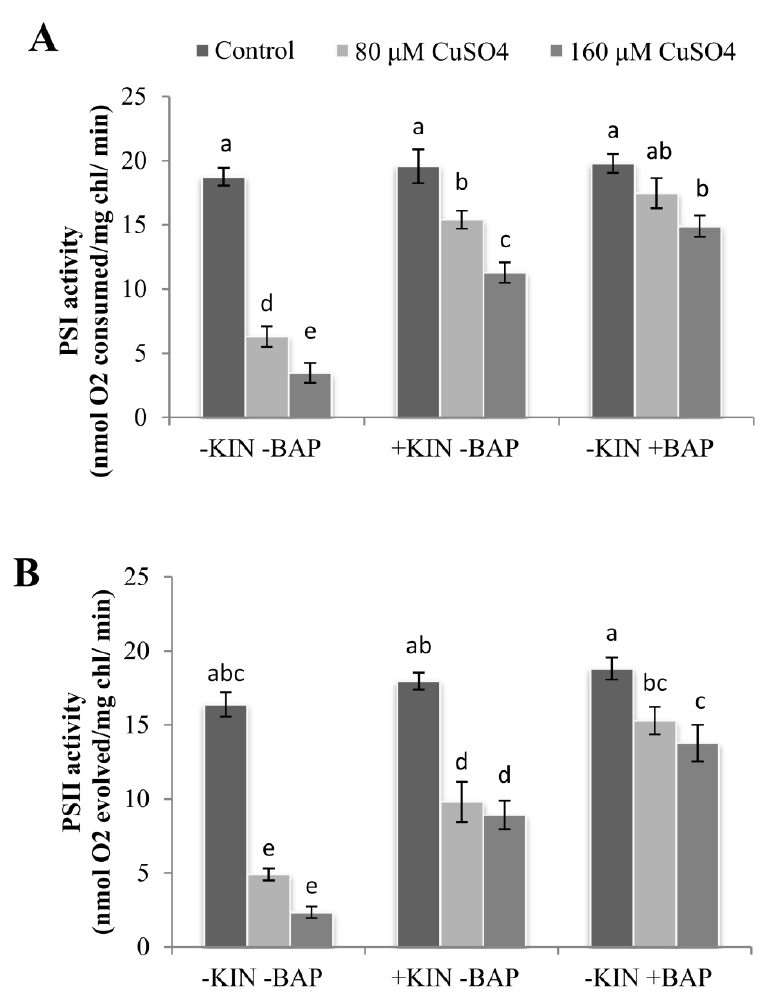
Figure 2. Photosystem (PS) I ( A ) and II ( B ) activities in the cotyledonary leaves of R. communis on 6 day of exposure to CuSO 4 (80 and 160 µ M) and cytokinin (KIN and BAP) treatments in Hoagland’s nutrient medium. Values are the mean ± SE of three independent experiments. Different alphabetical letters indicate significant differences between treatments according to one-way ANOVA (Duncan’s test p ≤ 0.05).